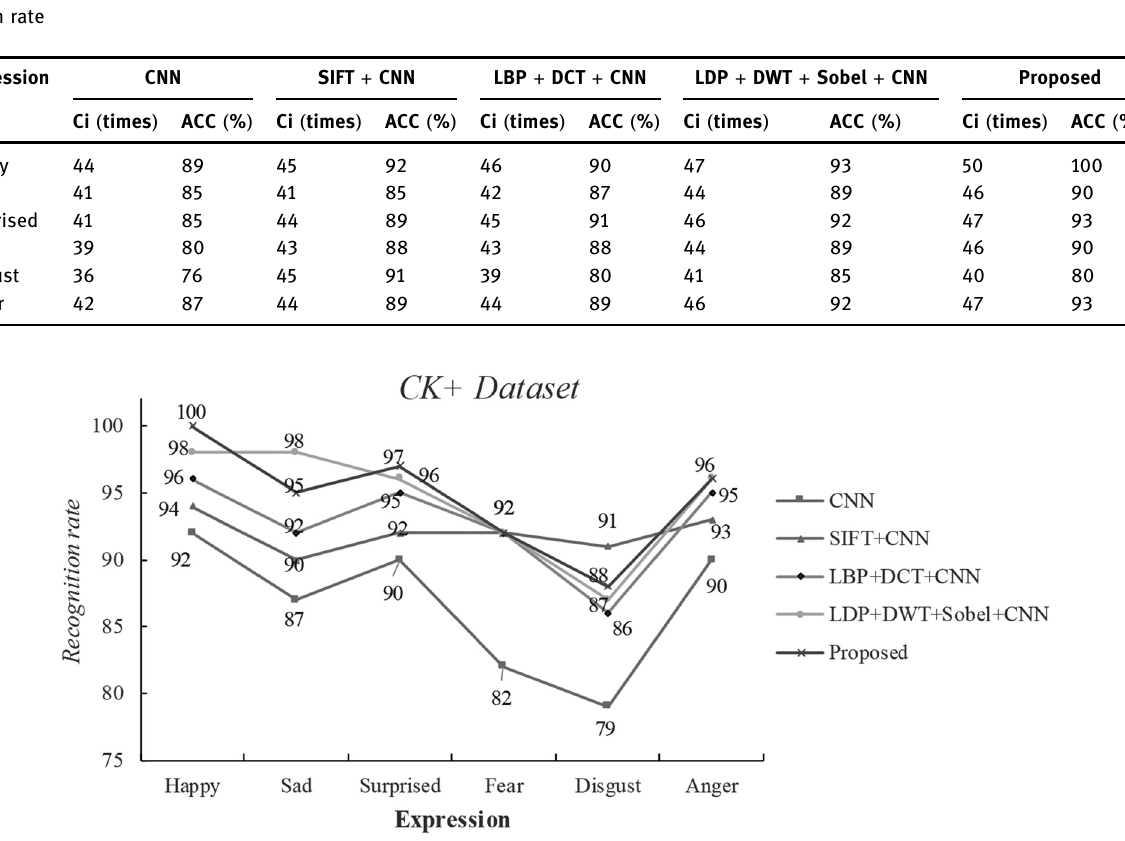
Figure 6: Result comparison of di ff erent algorithms in the CK + dataset.